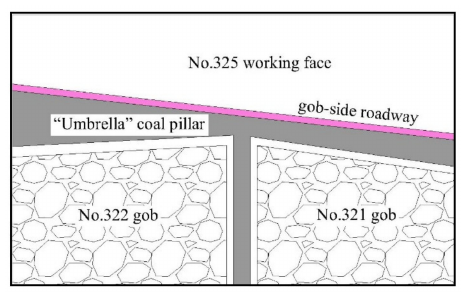
Figure 2. Schematic diagram of an “umbrella”-shaped coal